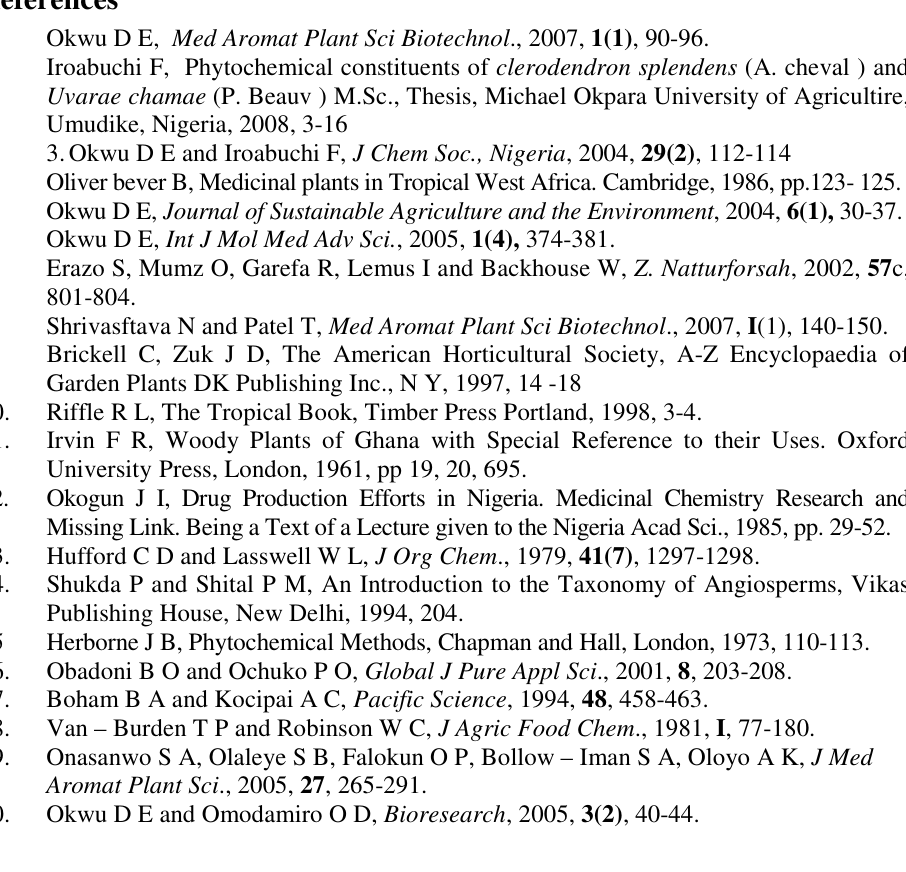
Data are means ± standard deviation of three determinations values at the